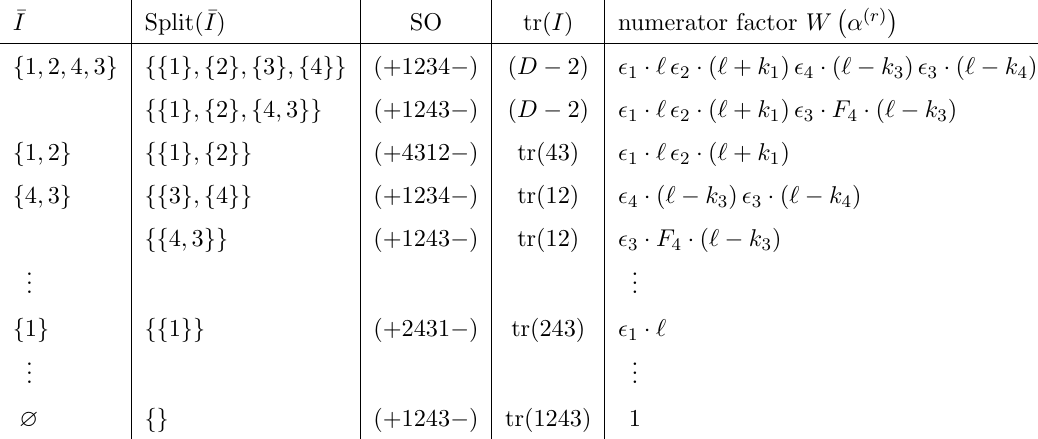
Table 3 . Contributions to the master numerator N